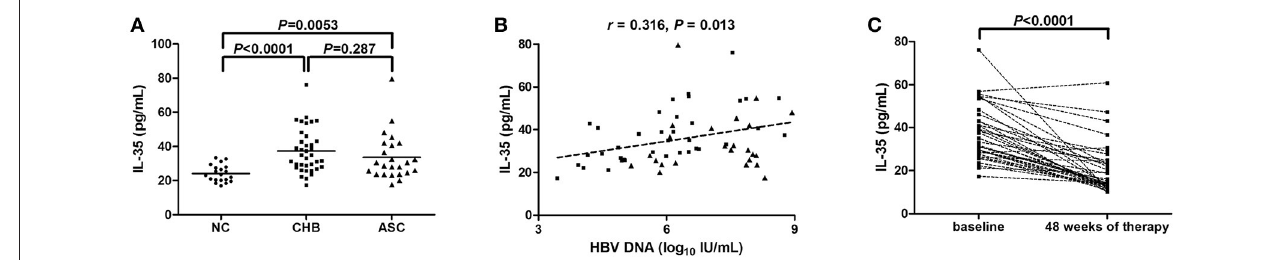
FIGURE 1 | Interleukin (IL)-35 expression in patients with chronic hepatitis B virus (HBV) infection. (A) The concentration of IL-35 in the serum was measured by enzyme-linked imunosorbent assay (ELISA) in normal controls (NCs, n = 20), patients with chronic hepatitis B (CHB, n = 37), and asymptomatic HBV carriers (ASC, n = 24). Horizontal bars indicate mean value of each subset, and the individual level for each subject is shown. Significances were calculated using SNK- q test. (B) Pearson correlation analysis of IL-35 concentration with HBV DNA in 61 patients with chronic HBV infection (including CHB and ASC). (C) IL-35 concentration in the serum was also measured by ELISA in CHB patients receiving 48-week of entecavir therapy. The individual level for each subject is shown. Significance between baseline and 48 weeks post-therapy was calculated using paired t- test.